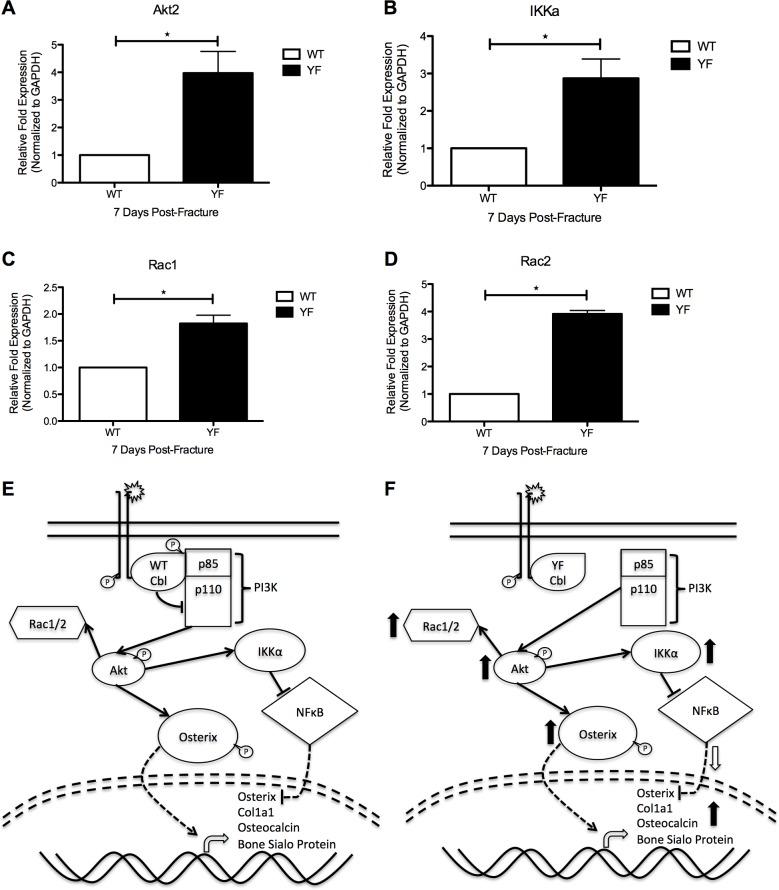
Molecular and functional changes in osteoblasts and osteoclasts of YF fracture calluses may be due to increased PI3K signaling.Cells from sections of fracture calluses at 7 days post-fracture were harvested by LCM and expression of A. Akt2 B. Ikkα C. Rac1, and D. Rac2 were quantified by RT-PCR. n = 3 *p<0.05 vs. WT. E. Proposed schematic of molecular mechanism in WT mice. F. Proposed schematic of molecular mechanism in the absence of Cbl-PI3K interaction (YF mice).